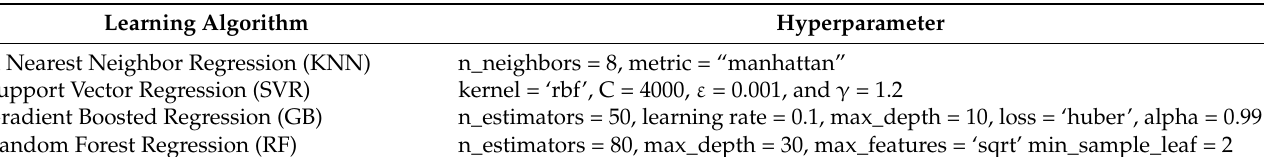
Table 5. Optimum hyperparameters used for predicting CO 2 fluxes.